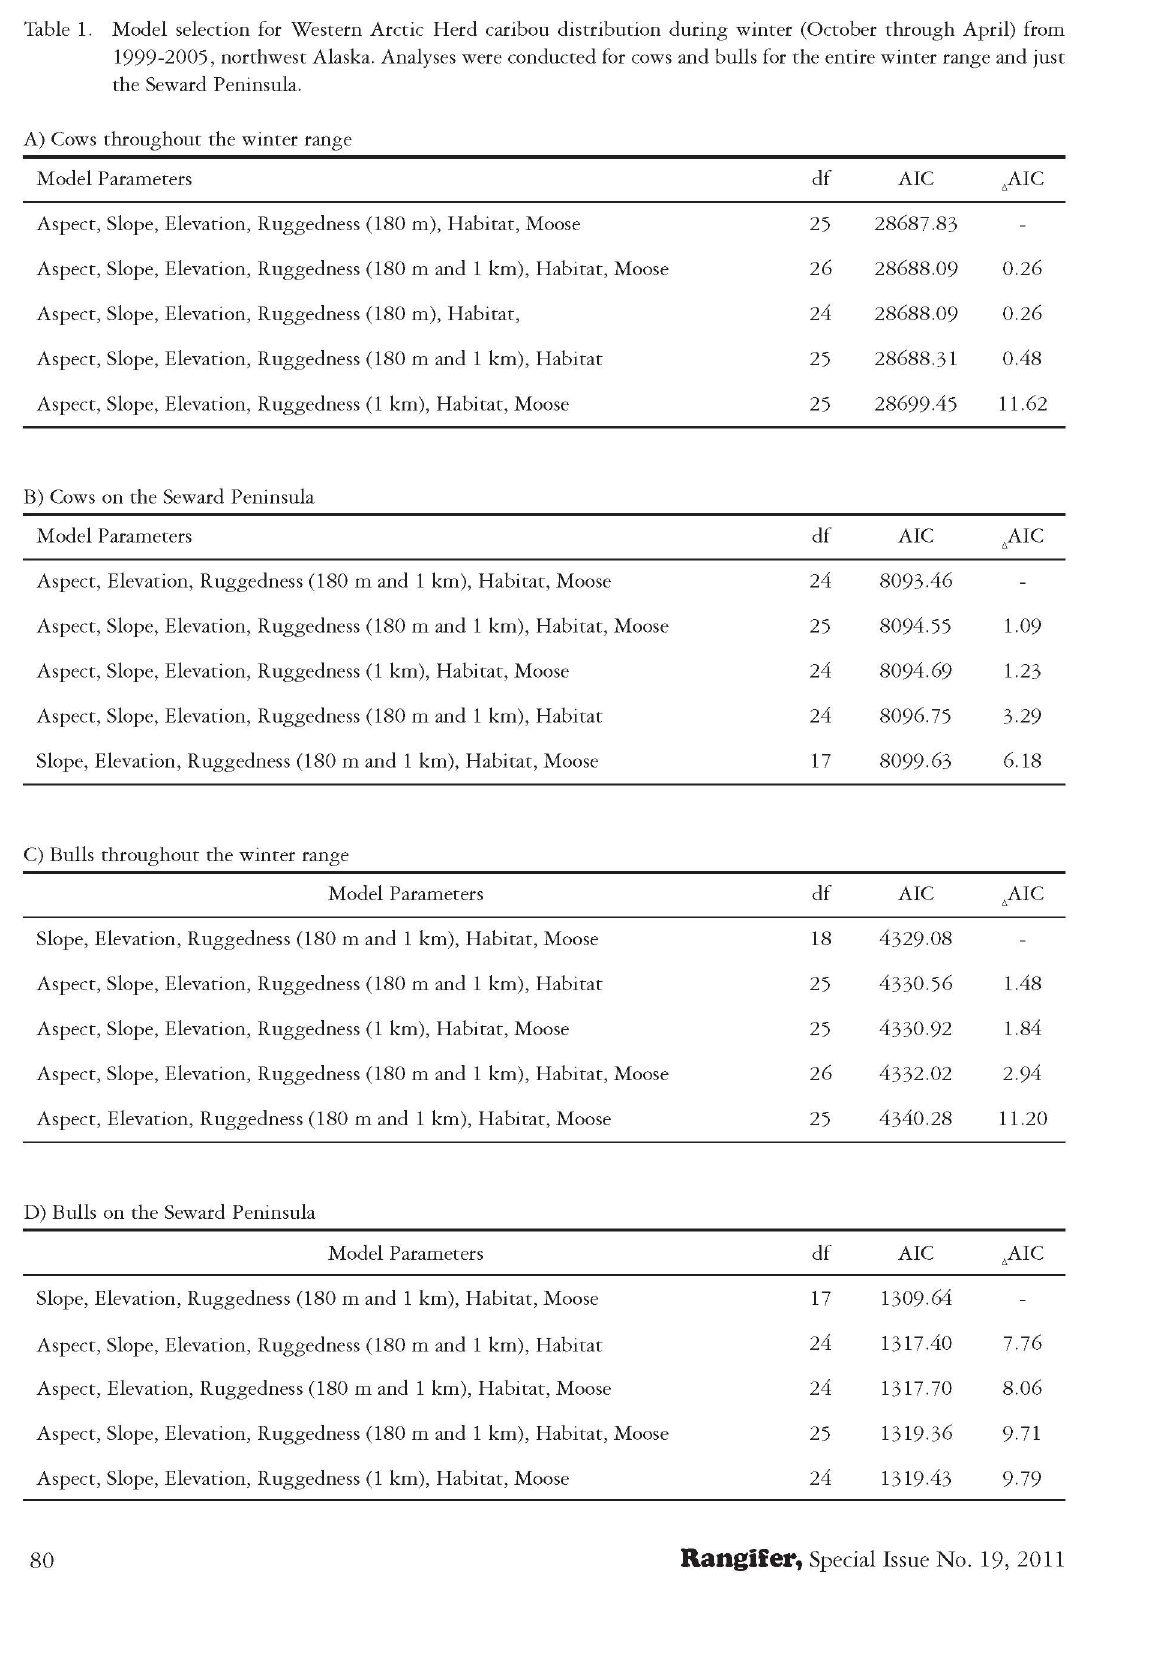
Table 1. Model selection for Western Arctic Herd caribou distribution during winter (October through April) from 1999-2005, northwest Alaska. Analyses were conducted for cows and bulls for the entire winter range and just the Seward